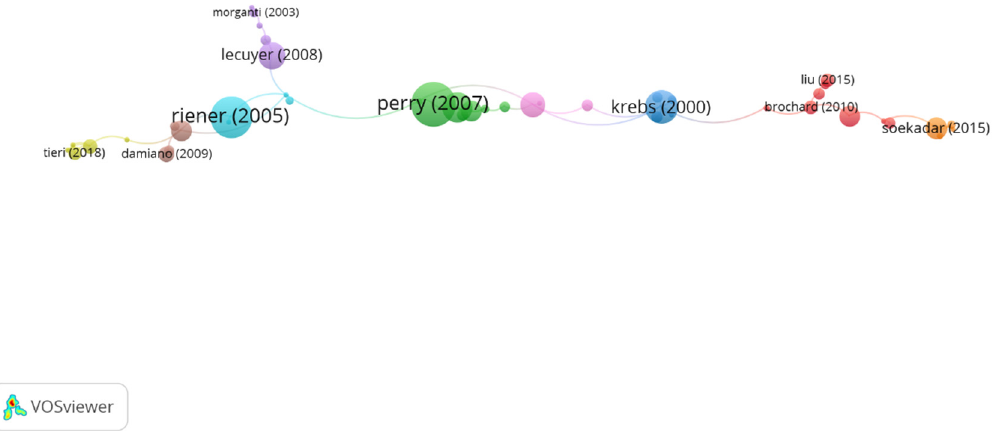
Figure 9. Core publications in the citation network about new technologies in neurorehabilitation.